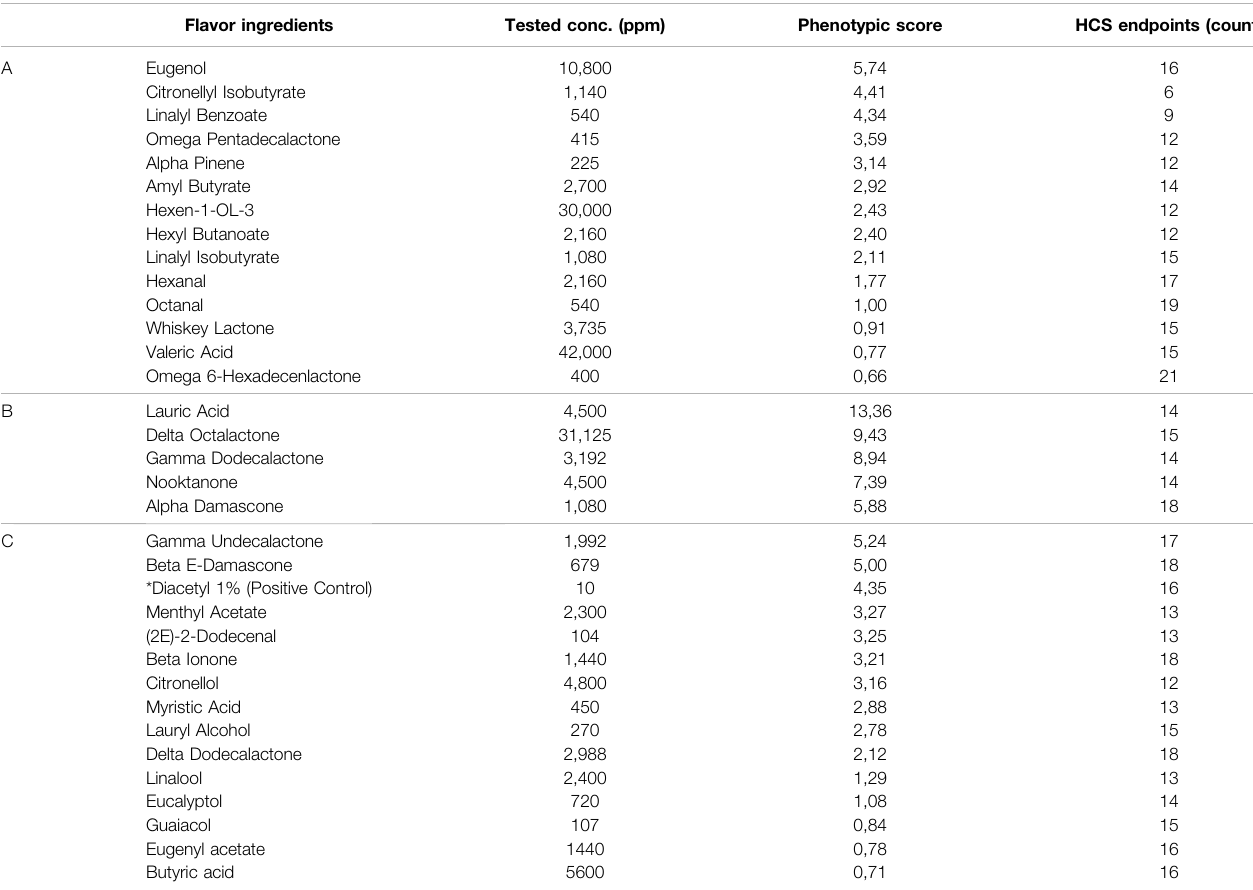
TABLE 2| Phenotypicscores(ratioofMECbasesolution/MEC fl avored solution)andHCSendpointscounts(numberofendpointswhichreturned acomputed MEC;higher is the number the more biological pathways are activated) for the 34 individual fl avor ingredients that were evaluated using an HCS approach. Diacetyl is not included in the list of fl avor ingredients and was added here only as a positive control. Flavor